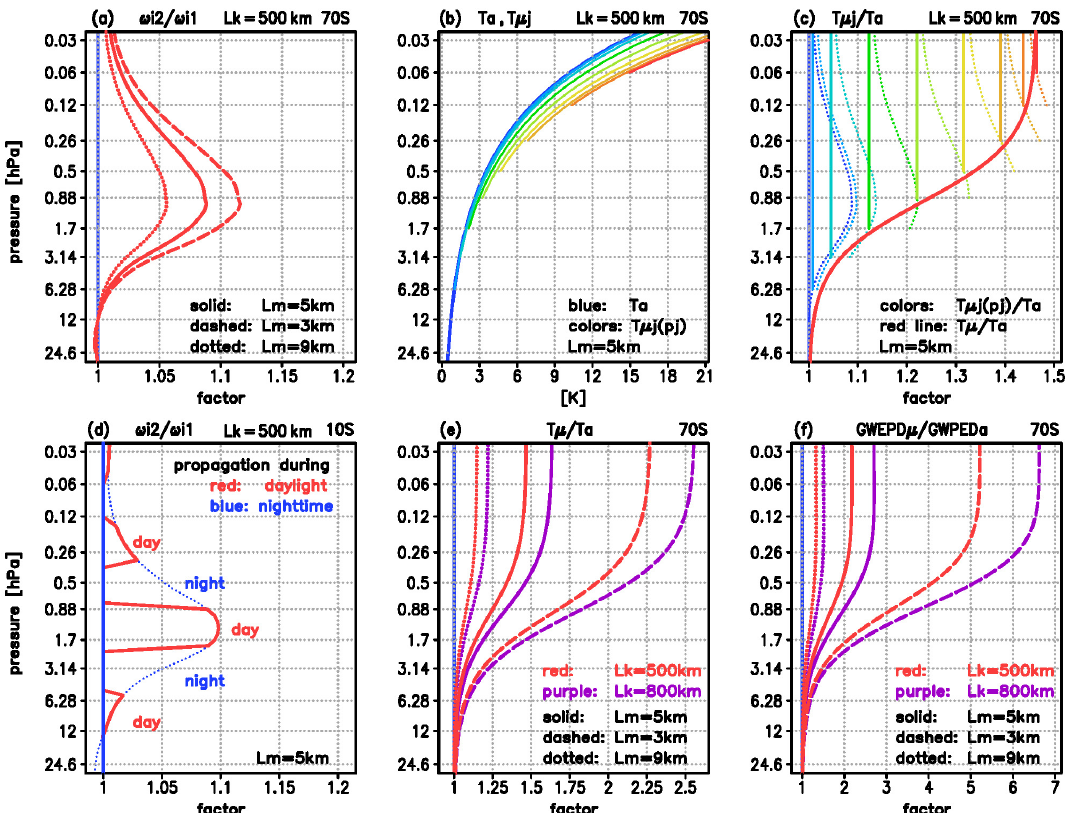
Figure 4. Illustration of the successive amplification of GW amplitudes during the upward level-by-level propagation. (a) Amplification factor ω i 1 /ω i 2 at 70 ◦ S for GW with horizontal wavelength L k = 500km and vertical wavelength L m = 5km (solid red line), and, for comparison, L m = 3 (dashed) and L m = 9km (dotted). (b) Temperature amplitudes for GW with L k = 500km and L m = 5km, depicting the initial perturbation T a (blue) and the successively amplified amplitudes T µj ( z j ) | j = 1 ,n (light blue towards red; here, n = 8 for L m = 5km). (c) Same as (b) but for the relative amplitudes T µj ( z j ) | j /T a (solid lines) together with the profiles of the previous level multiplied by ω i 1 /ω i 2 (i.e., T µj − 1 ( z j − 1 ) · ( ω i 1 /ω i 2 ), dashed lines) and a fitted approach T µ (thick solid red line, defined by Eq. 18). (d) Same as (a) for the case L k = 500km and L m = 5km but at 10 ◦ S including the limitation due to the length of nighttime conditions. (e) Relative values T µ /T a at 70 ◦ S for different horizontal (red: L k = 500km, purple: L k = 800km) and vertical (dashed: L m = 3, solid: L m = 5km, dotted: L m = 9km) wavelengths. (f) Same as (e) but for the relative values E µ /E a of the related gravity wave potential energy density (GWPED, defined by Eq.